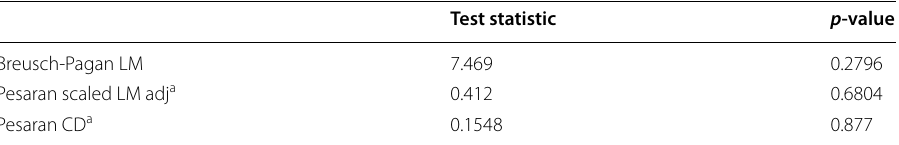
Under the null hypothesis of cross-section independence a Two-sided test